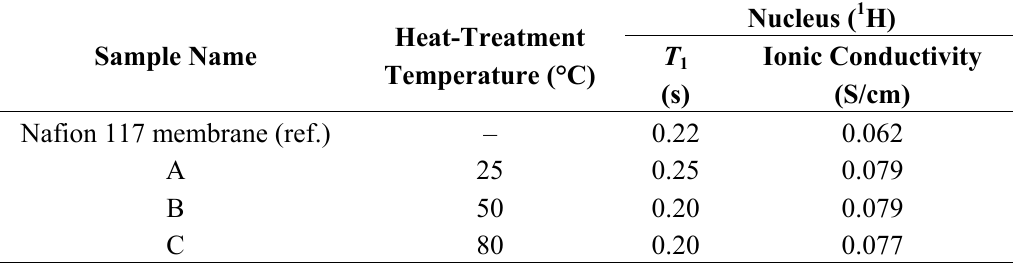
Table 2. 1 H NMR T , and ionic conductivity values for Nafion 117 membrane heat-treated 1 at 25, 50, and 80